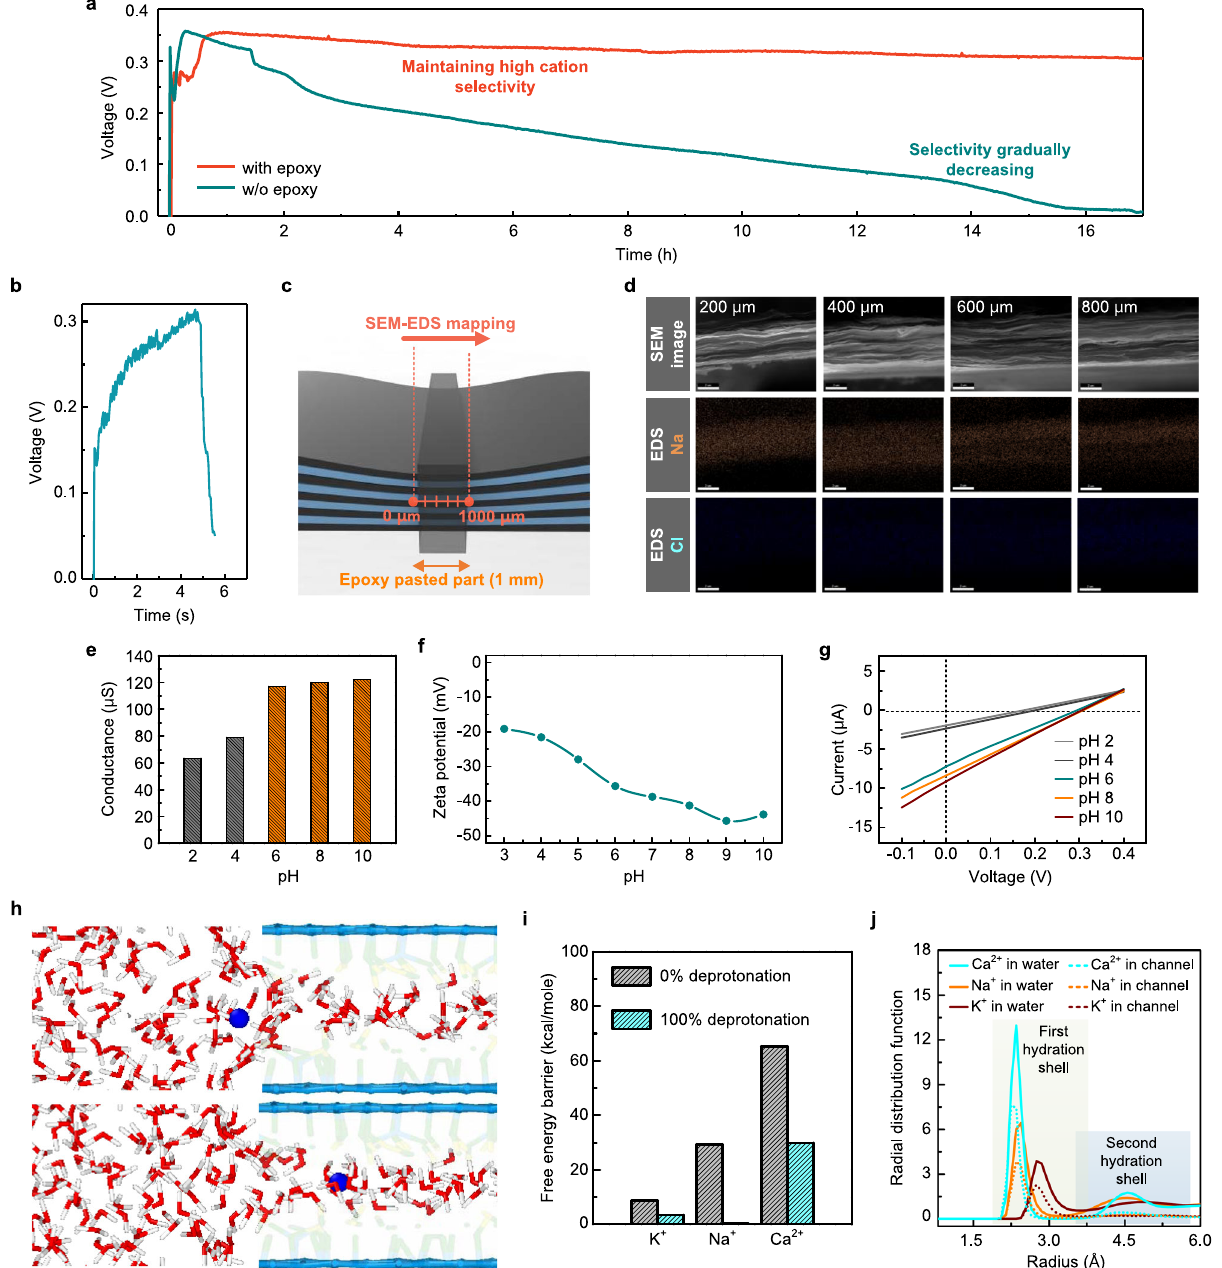
Fig. 3 Ion mobility of sodium ions in the angstrom-scale channel. a Open-circuit voltage with respect to time under a concentration gradient of 10 3 . Epoxy-pasted cells maintain a more stable voltage than non-epoxy-pasted cells. b Open-circuit voltage data with respect to time to assess the transition from non-steady-state to steady-state diffusion. c . Schematic of the part on which SEM – EDS mapping analysis is applied. d SEM – EDS mapping results of epoxy-pasted part (1 mm). Scale bars, 2 μ m. e Ionic conductance value of GO membrane as a function of pH at 1 M NaCl. f Zeta potential of GO. g I – V curve data under a concentration gradient of 10 3 across the channel with various pH conditions. h The simulation showing the ion entrance into the GO channel. Carbon atoms in GO sheets are shown as blue plates, oxygen as green spheres, hydrogen in yellow, Na + in blue, water oxygen in red, and water hydrogen in white. i Free energy barriers of ion dehydration when ions enter the GO channel. j Radial distribution function of oxygen atoms on water molecules around the ions in con fi ned GO channels and bulk